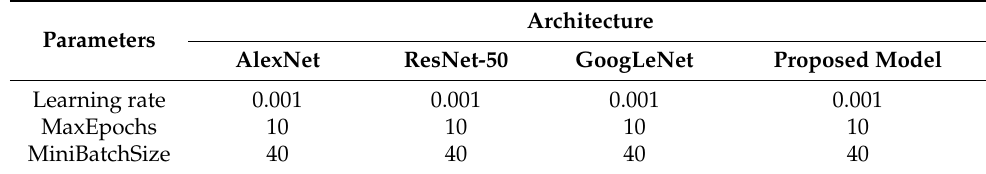
Table 4. CNN parameters used in training.